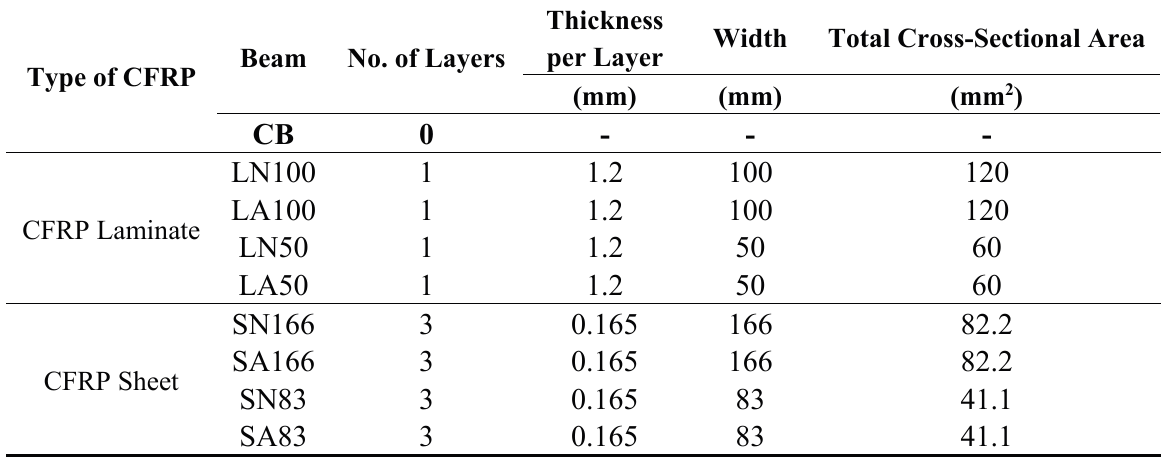
Table 2. CFRP laminate and sheet dimensions used to strengthen the test beams.